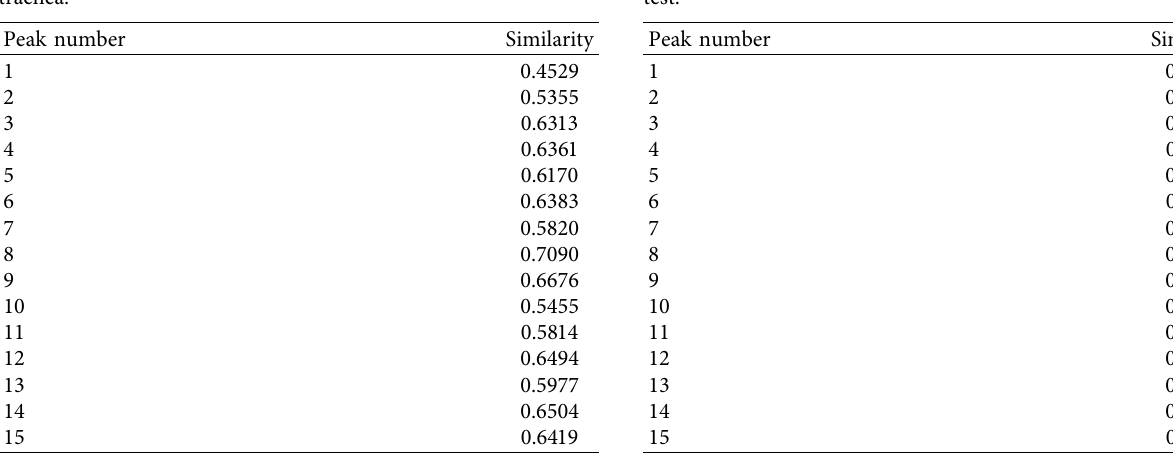
Table 5: Grey correlation between the common peaks of flavonoids from Glycyrrhiza uralensis Fisch. and ammonia-induced cough